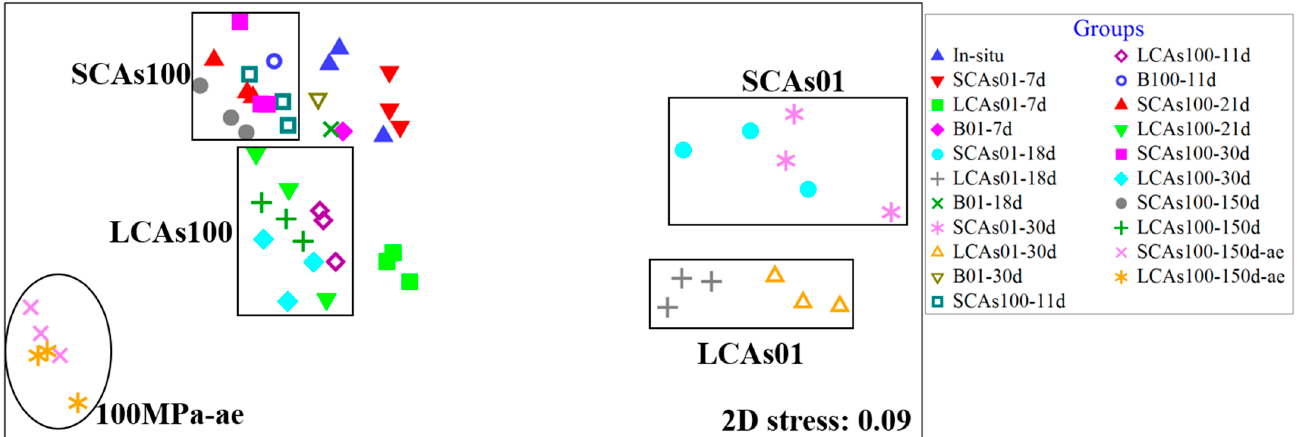
Figure 1. The non-metric multidimensional scaling (nMDS) analysis of microbial communities for aerobic and anaerobic hydrocarbon incubation at 0.1 and 100 MPa in the sediments of the Mariana Trench. Note: SCAs100, MT sediments added short-chain alkanes incubated anaerobically at 100 MPa; LCAs100, MT sediments added long-chain alkanes incubated anaerobically at 100 MPa; SCAs01, MT sediments added short-chain alkanes incubated anaerobically at 0.1 MPa; LCAs01, MT sediments added long-chain alkanes incubated anaerobically at 0.1 MPa; 100 MPa-ae, MT sediments added short-chain or long-chain alkanes incubated aerobically at 100